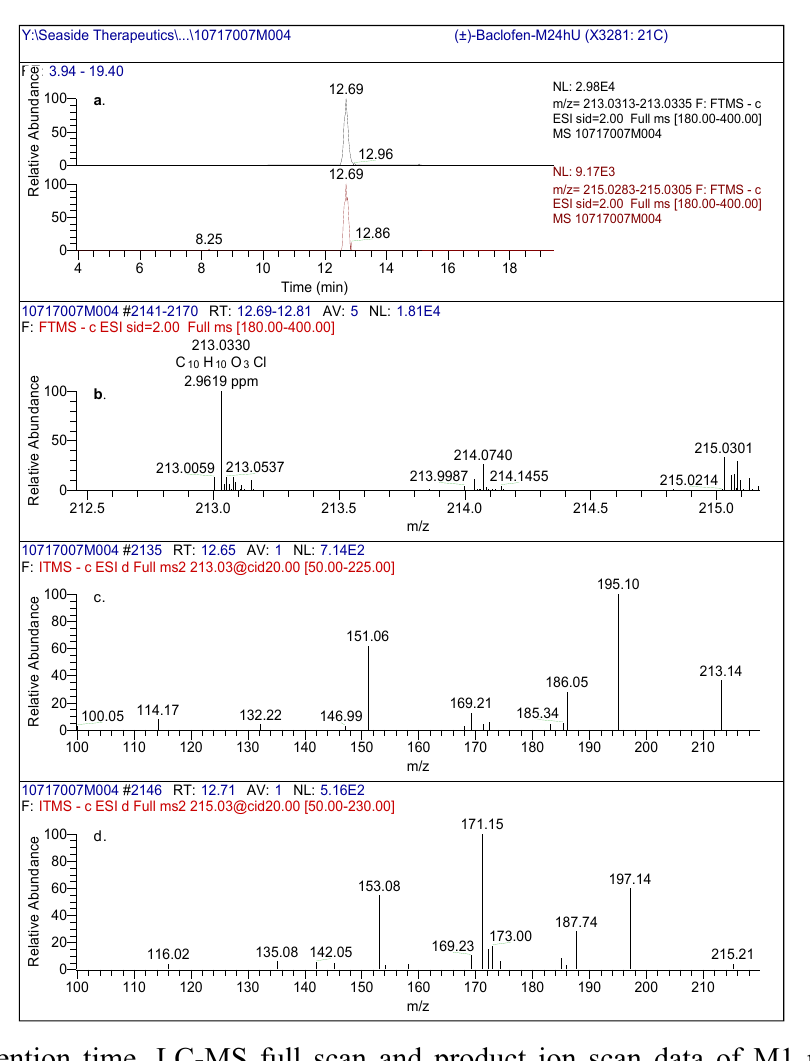
Figure 4. ( a ) High resolution extracted ion chromatogram of pooled human urine (0-24 hr) after administration of racemic baclofen using the exact mass of [M1-H]- and [M1+2-H]- ( b ) full scan spectrum of the chromatographic eluting peak at 12.69 min. ( c ) (-)CID- MS/MS spectral data using [M1-H]- (213m/z) as the precursor ion and ( d ) (-)CID-MS/MS spectral data using [M1-H]- (215m/z) as the precursor